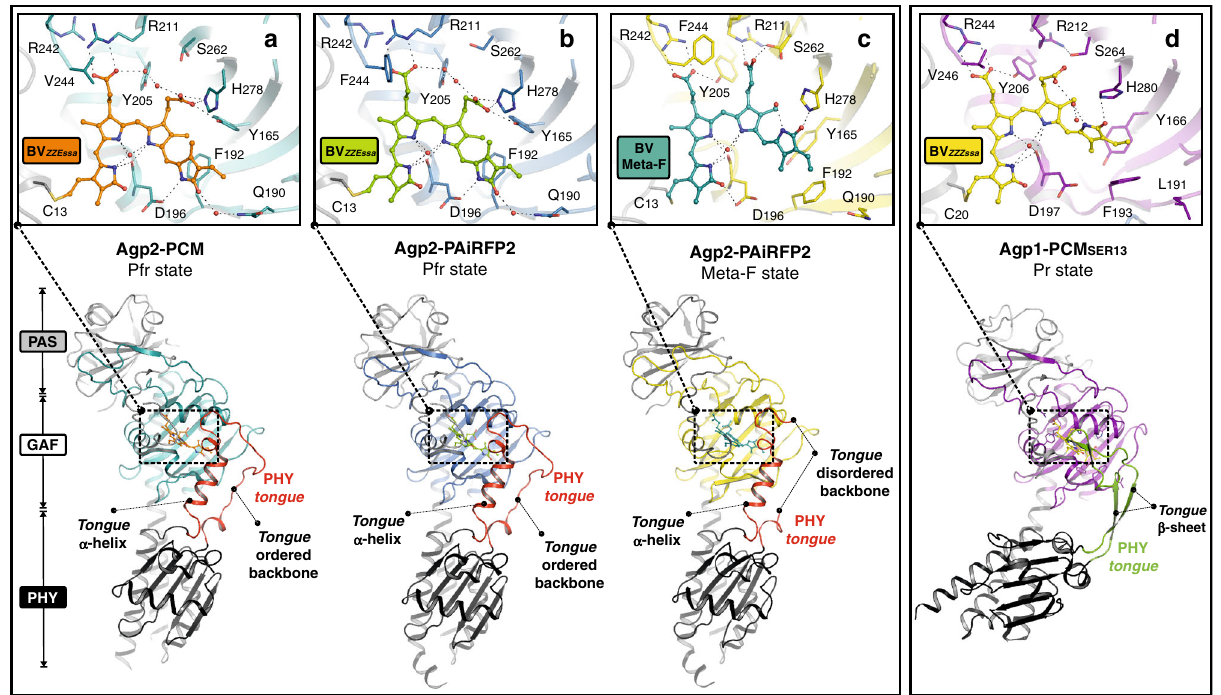
Fig. 2 Overview of the crystal structures of bacterial phytochromes from A. fabrum . Structures (ribbon representation) of the monomers are shown for the dark adapted Pfr state of a wild-type Agp2-PCM (PDB entry 6G1Y) and b Agp2-PAiRFP2 (PDB entry 6G1Z), c a Meta-F sub-state (Mol A) of the Agp2- PAiRFP2 (PDB entry 6G20) and d the Pr state of the Agp1-PCM (Agp1-PCM SER13 of A. fabrum , PDB entry 5HSQ 30 ). Close-up view of the chromophore- binding pockets ( a – d ) including BV and amino acid residues within the hydrogen bond network of BV (stick representation) as well as selected water molecules (red spheres). PAS domains are displayed in grey, PHY domains in black and GAF domains are depicted in different